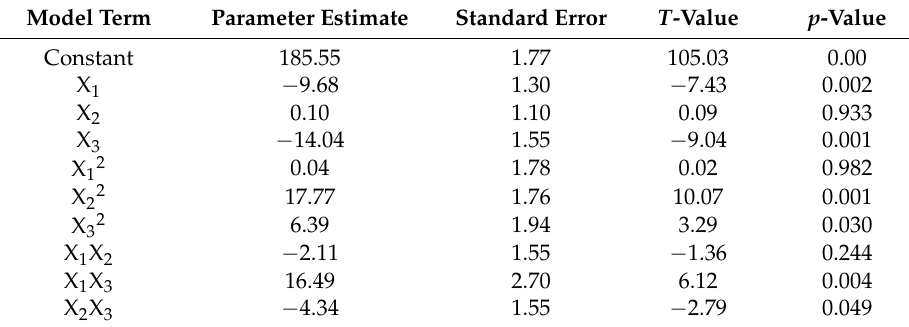
Table 8. Statistical significance of the coefficient of regression.